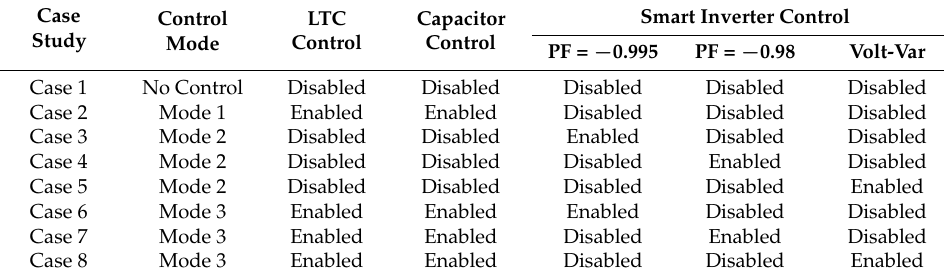
Table 2. Voltage control case